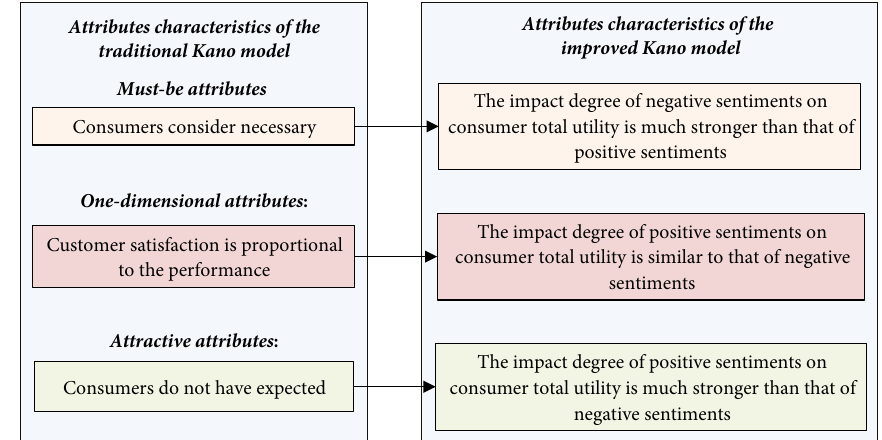
Figure 10. Feature comparison of three attribute